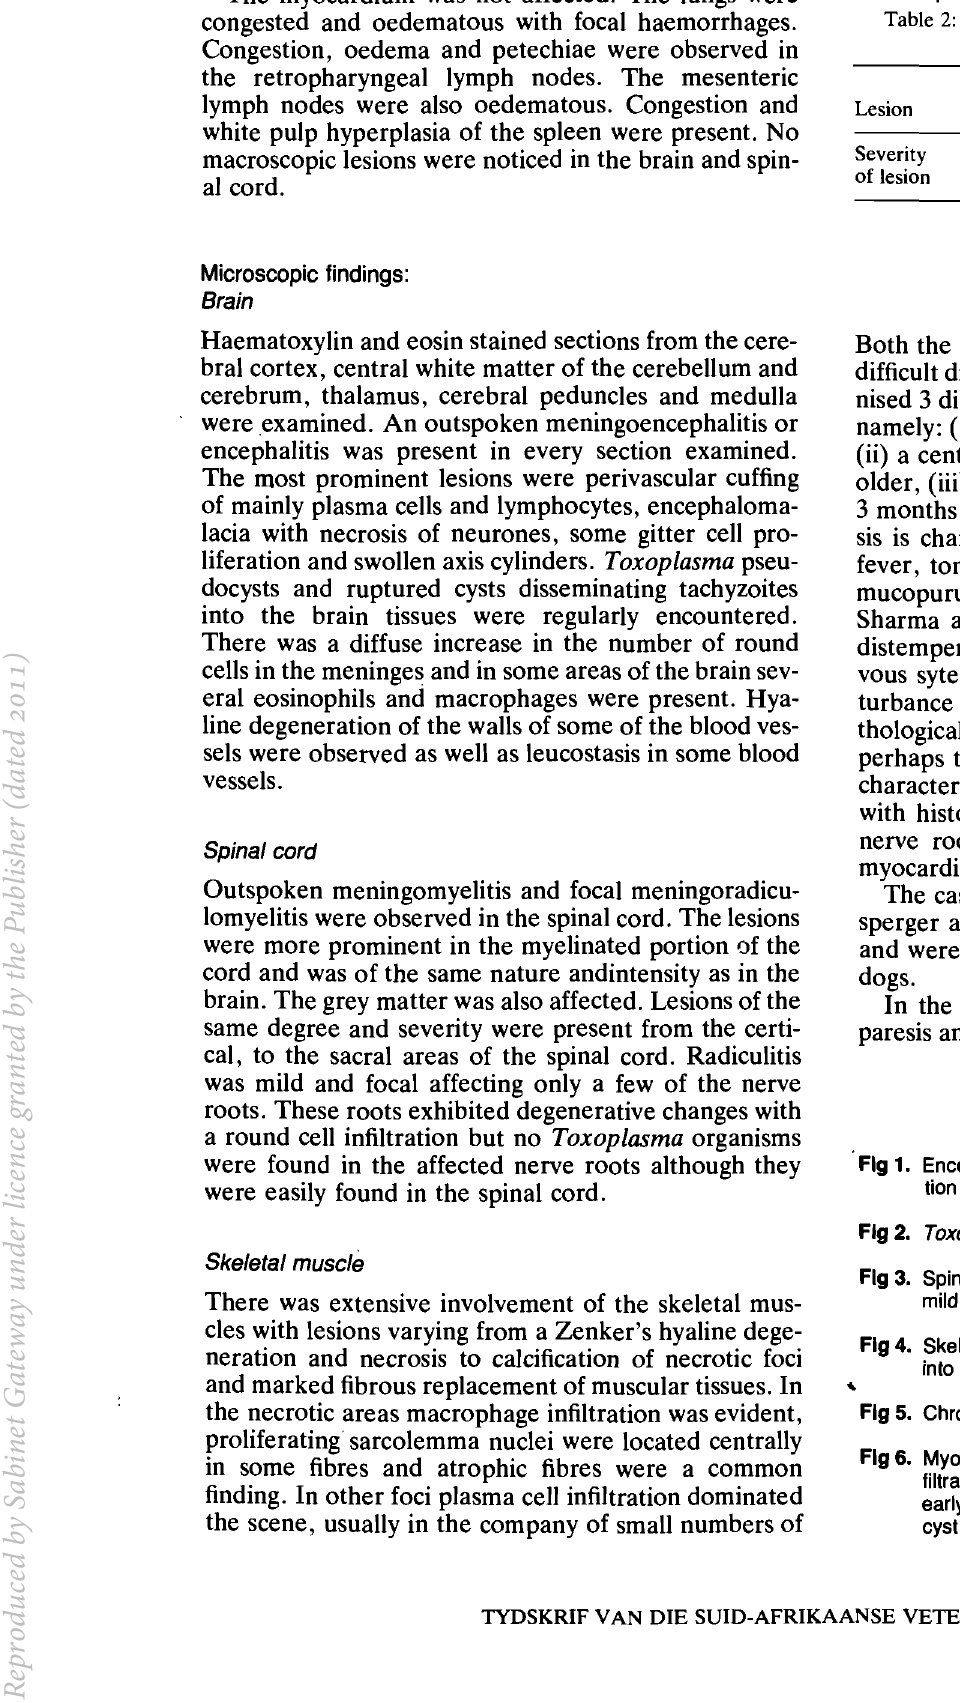
Table 2: SUMMARY OF SQME OF THE MicROSCOPIC FINDINGS